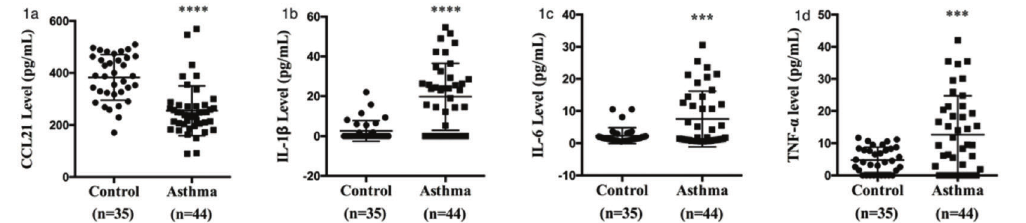
Figure 1 - Comparison of serum cytokine levels between patients with asthma and healthy controls. (a) Serum CCL21 levels were determined by ELISA. (b) IL-1 b , (c) IL-6, and (d) TNF- a levels were analyzed by cytometric beads array. Statistical analysis was performed